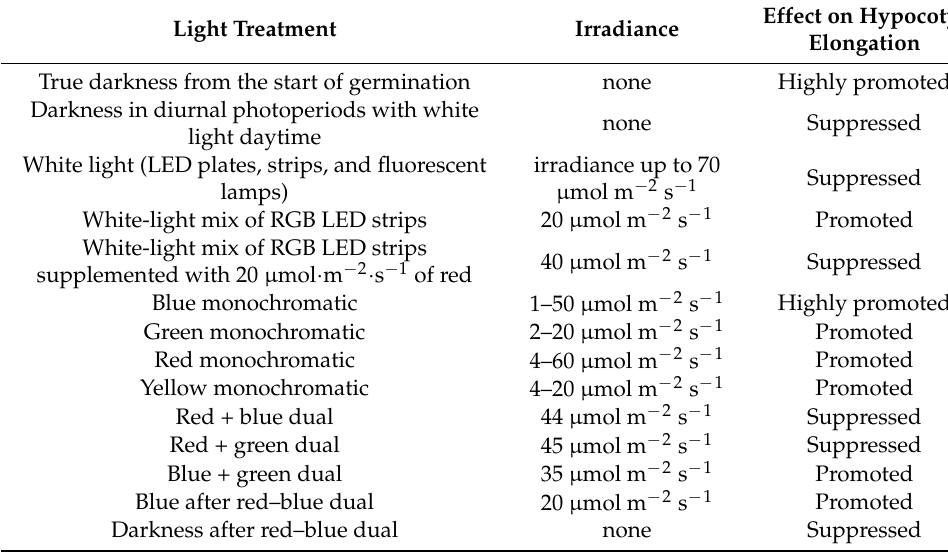
Table 1. Overview of the light quality (waveband composition) used in the treatments, their irradiance levels, and their effects on hypocotyl elongation. Effect on Hypocotyl Light Treatment Irradiance Elongation True darkness from the start of germination none Highly promoted Darkness in diurnal photoperiods with white none Suppressed light daytime White light (LED plates, strips, and fluorescent irradiance up to 70 Suppressed µ mol m − 2 s − 1 lamps) White-light mix of RGB LED strips 20 µ mol m − 2 s − 1 Promoted White-light mix of RGB LED strips 40 µ mol m − 2 s − 1 Suppressed supplemented with 20 µ mol · m − 2 · s − 1 of red Blue monochromatic 1–50 µ mol m − 2 s − 1 Highly promoted Green monochromatic 2–20 µ mol m − 2 s − 1 Promoted Red monochromatic 4–60 µ mol m − 2 s − 1 Promoted Yellow monochromatic 4–20 µ mol m − 2 s − 1 Promoted Red + blue dual 44 µ mol m − 2 s − 1 Suppressed Red + green dual 45 µ mol m − 2 s − 1 Suppressed Blue + green dual 35 µ mol m − 2 s − 1 Promoted Blue after red–blue dual 20 µ mol m − 2 s − 1 Promoted Darkness after red–blue dual none